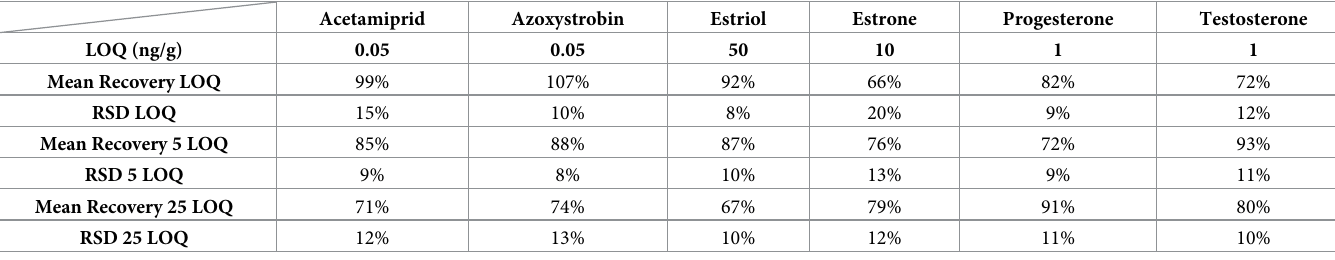
Table 1. Quantification limit using LC-MS/MS for acetamiprid, azoxystrobin, estriol, estrone, progesterone, and testosterone in rat liver.